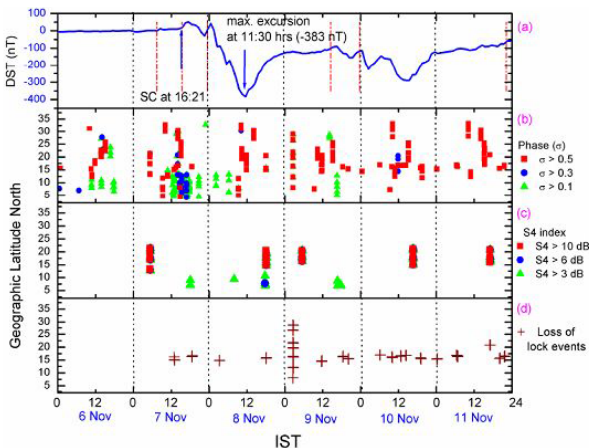
Fig. 7. Occurrence of phase slips as a function of latitude and local time (a) D st variation during 6–11 November 2004 (b) associated with phase index ( σ) , (c) S4 index, and (d) the resulting loss of lock events during the storm period, 6–11 November